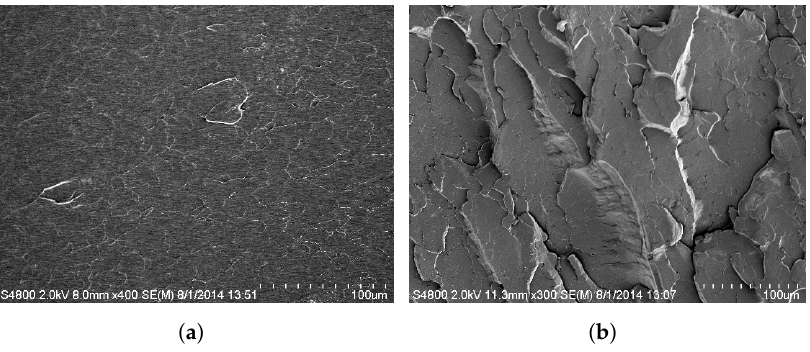
Figure 8. Scanning electron microscopy image of 1 wt.% and 8 wt.% POSS loading shows the toughening mechanism due to POSS inclusion. ( a ) Fractured surface of 1 wt.% POSS inclusion. ( b ) Fractured surface of 8 wt.% POSS